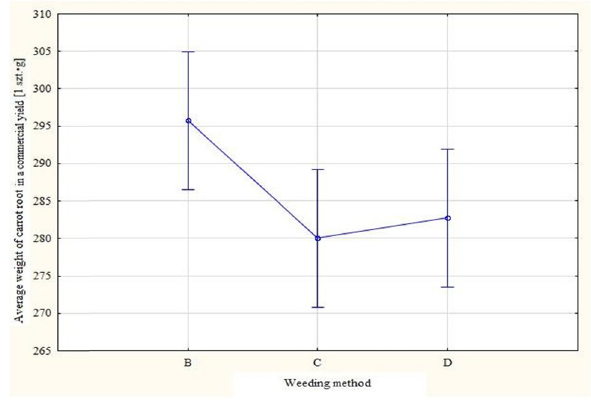
Figure 11: The expected marginal averages for 0.95 con fi dence intervals for the average weight of carrot root in various weeding methods in 2017 ( source: own work ) .